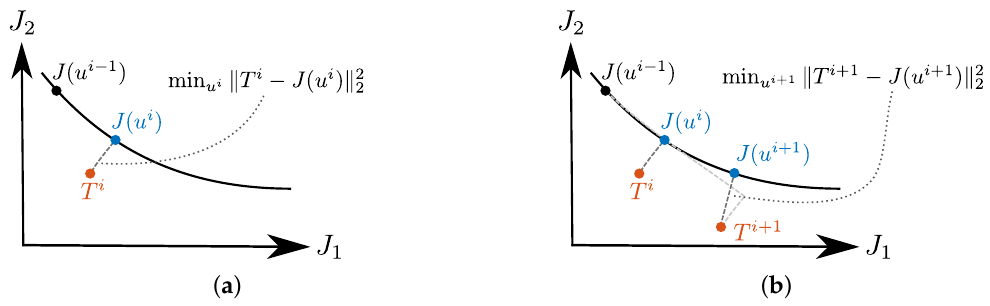
Figure 6. Reference point method. ( a ) Determination of a Pareto-optimal solution by solving (13). ( b ) Determination of the consecutive point on the Pareto front by adjusting the target and solving the next scalar